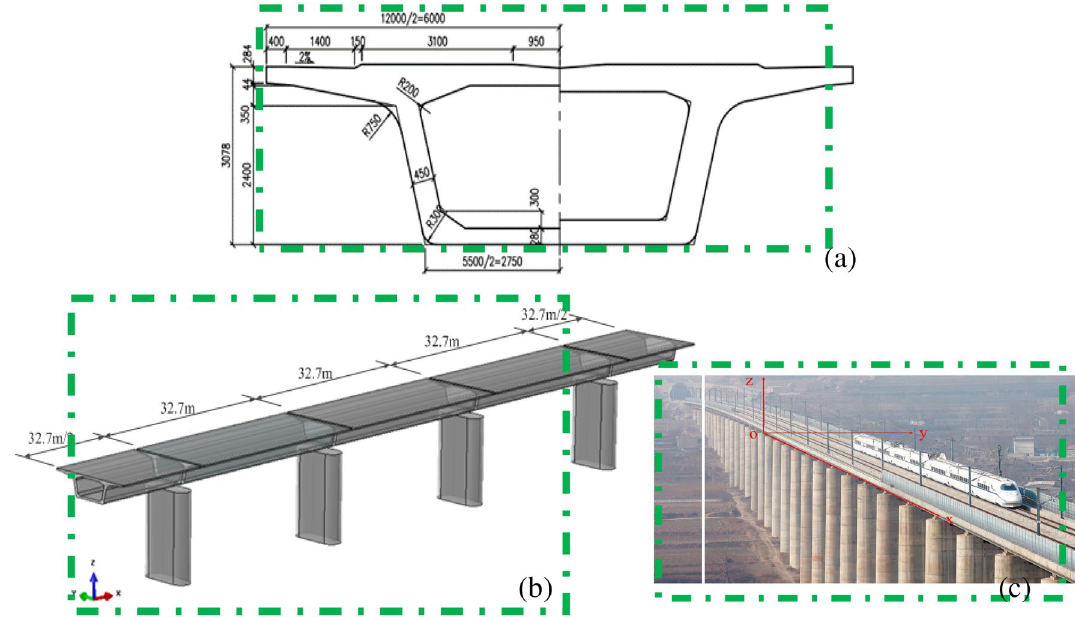
Figure 2. Prototype of a multi-span precast-simply-supported-beam-bridges for HSR (unit: